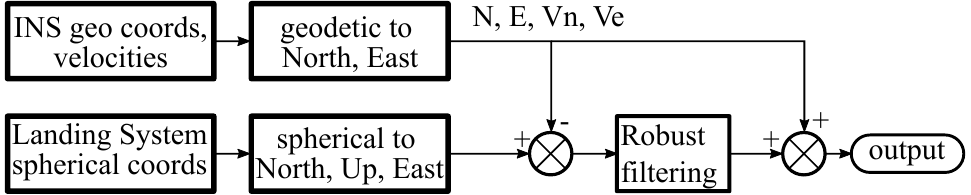
Figure 4. The inertial navigation systems (INS) correction